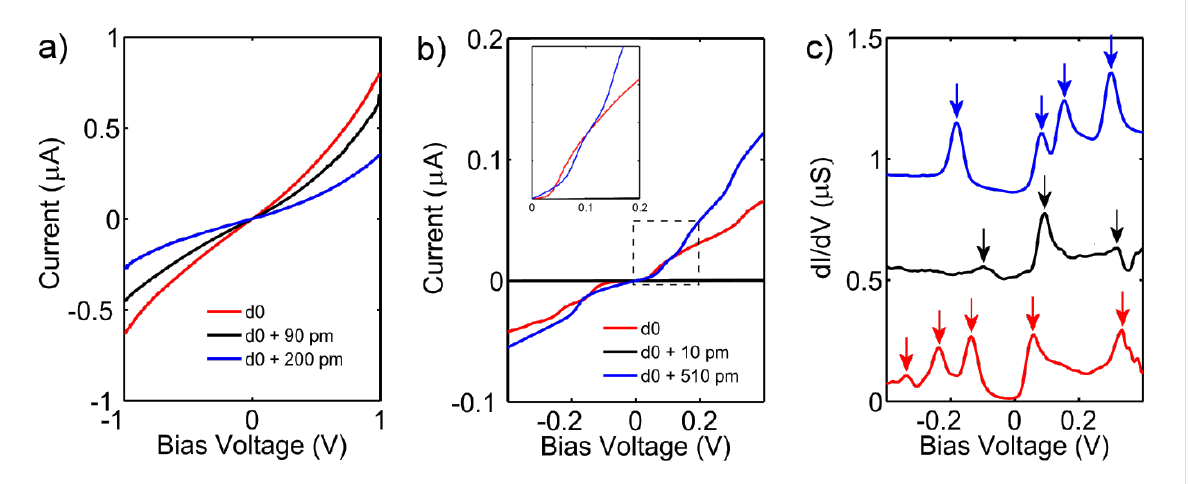
Figure 3: Low-temperature I ( V ) characteristics of junctions exposed to (a) DCM and (b) ZnTPPdT–Pyr. The DCM sample clearly shows vacuum- tunneling behavior. The porphyrin sample exhibits Coulomb blockade and steps. (c) d I /d V of a junction exposed to a ZnTPPdT–Pyr solution; curves are offset vertically for clarity. Resonances correspond to electronic or vibrational energy levels of the molecular junction. Note, for the black line the d I /d V has been scaled by a factor of